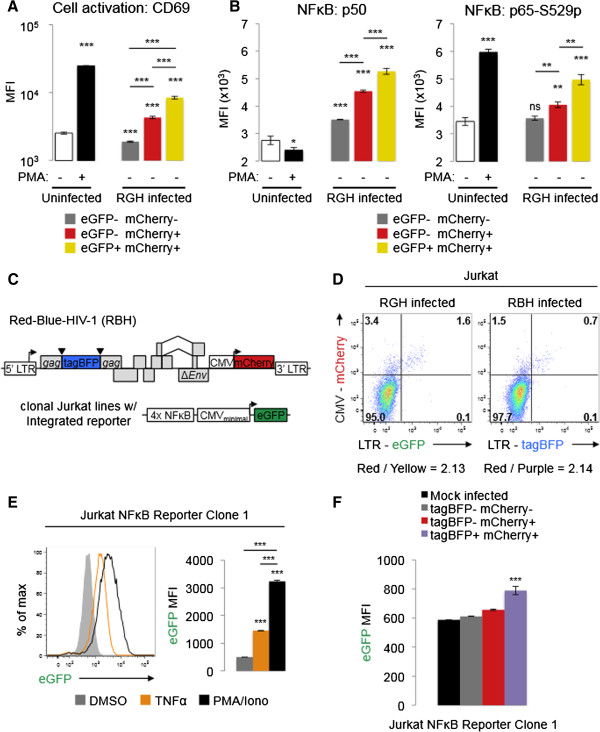
Non-productive RGH infection inversely correlates with both cellular activation and NFκB activity. A: RGH infected Jurkat cells (four days post-infection) were assayed for cellular activation by staining with anti-CD69 antibodies and analysis by flow cytometry. Uninfected cells were treated with either DMSO or PMA/Ionomycin for 24 hours prior to analysis. Error bars represent standard deviations of triplicate experiments. * p < 0.05, *** p < 0.001 (Student’s T test). B: Four days post-infection, RGH infected Jurkat cells were stained for NFκB p50 (left panel) and p65-S529-phospho (right panel) subunits and analyzed by flow cytometry. Uninfected cells were treated with DMSO or PMA/Ionomycin for 30 min prior to analysis. Error bars represent standard deviations of triplicate experiments. ‘ns’ non-significant, * p < 0.05, ** p < 0.01, *** p < 0.001 (Student’s T test). C: Schematic representation of Red-Blue-HIV-1 (RBH) and NFκB-eGFP reporter cell lines. RBH contains tagBFP in place of eGFP but is otherwise isogenic. Jurkat NFκB reporter cell lines contain a stably integrated eGFP marker driven by an NFκB responsive promoter (4x tandem NFκB cis-elements ‘GGGACTTTCC’ upstream of a CMV minimal promoter). D: Jurkat cells were infected with comparable amounts of RGH and RBH viral stocks. Cells were analyzed by flow cytometry four days post-infection. Plots shown are representative of multiple independent infection experiments. E: Jurkat NFκB reporter clone 1 was treated with DMSO, TNFα, or PMA/Ionomycin for 24 hours prior to analysis by flow cytometry for eGFP mean fluorescence intensity (MFI). Error bars represent one standard error of the mean. *** p < 0.001 (Student’s T test). F: Jurkat NFκB reporter clone 1 was infected with RBH and analyzed by flow cytometry at four days post-infection. Cells were gated into their constituent infected populations and then analyzed for eGFP MFI. Error bars represent one standard error of the mean. *** p < 0.001 (Student’s T test).